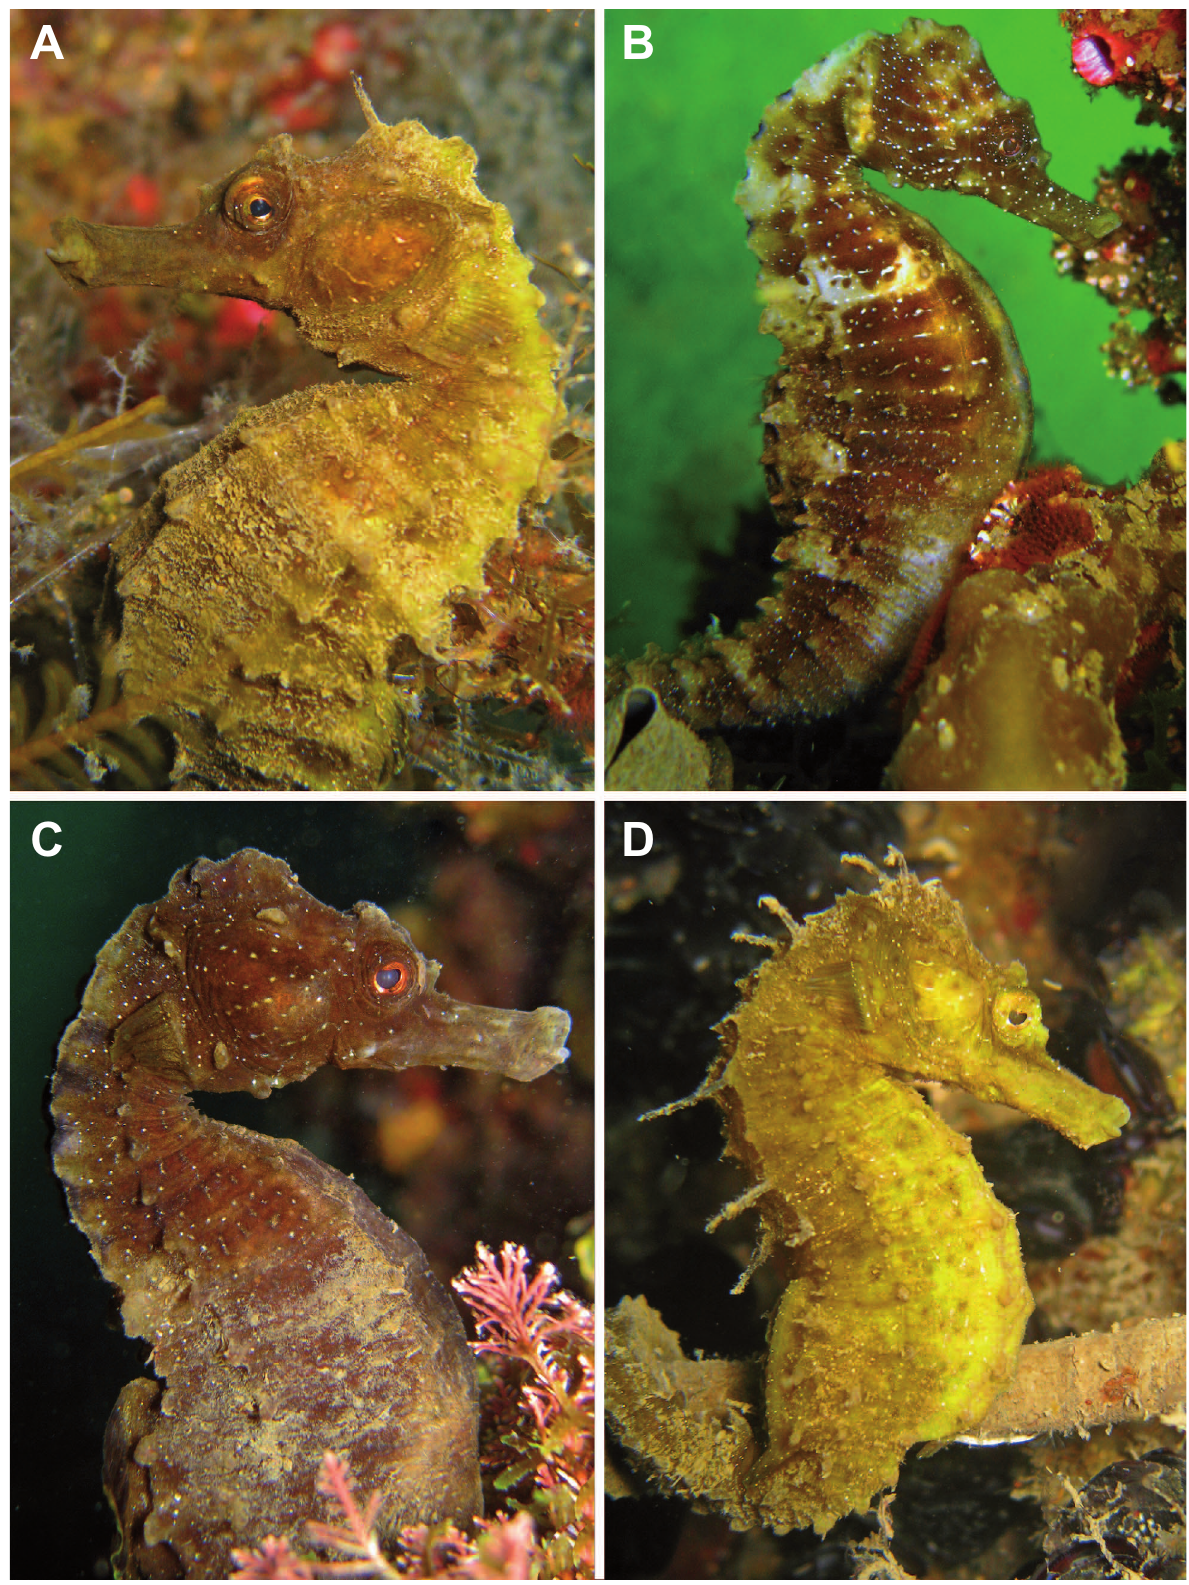
Fig. 1. Selected specimens of Hippocampus guttulatus observed during the diving visual census carried out in the Mar Piccolo of Taranto (Ionian Sea) within 2011–2013; Note that some of these specimens are without skin filaments ( B , C ) or with few skin filaments ( A , D